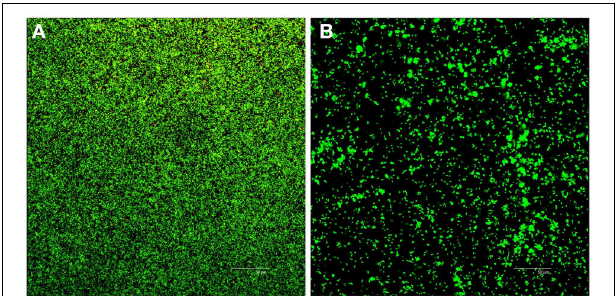
FIGURE 1 | Confocal analysis of 24-h biofilms of E. faecalis in TSB and pH 10 media. Live bacteria are green, and dead cells are visualized in red.